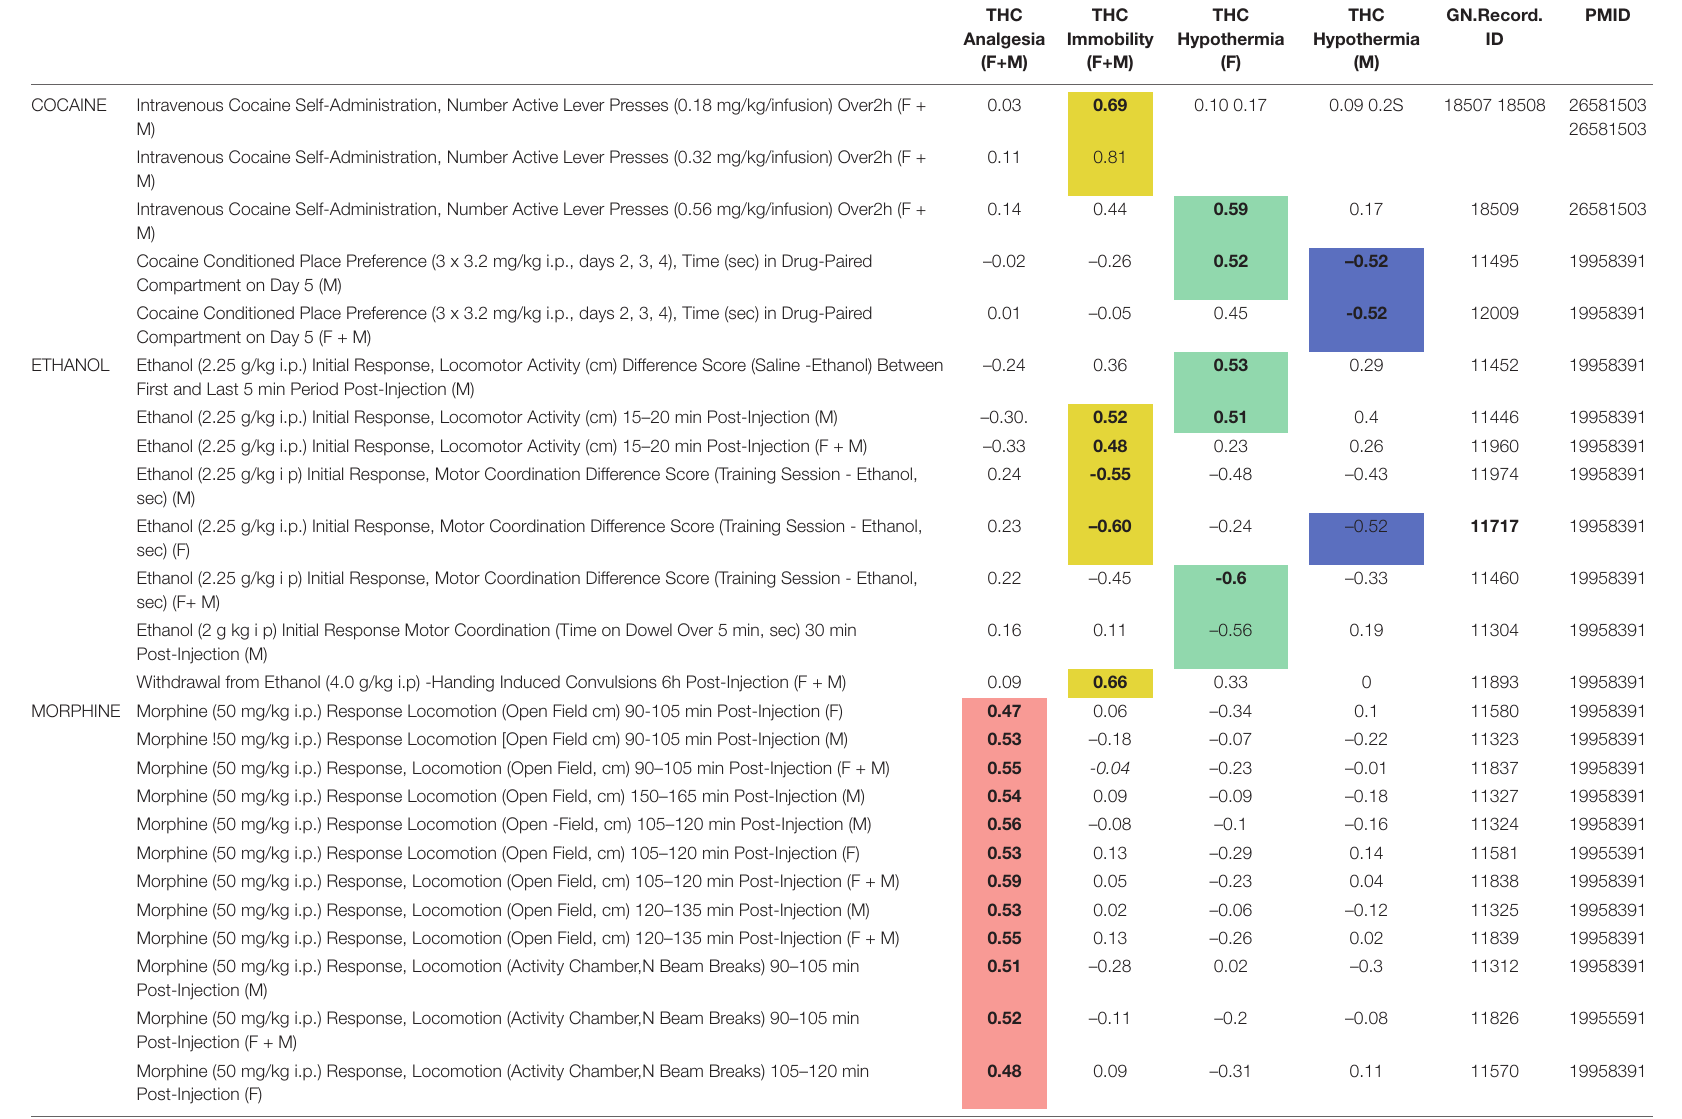
TABLE 4 | Summary of significant ( p < 0.05) correlations between initial response to THC and BXD legacy drug response traits.